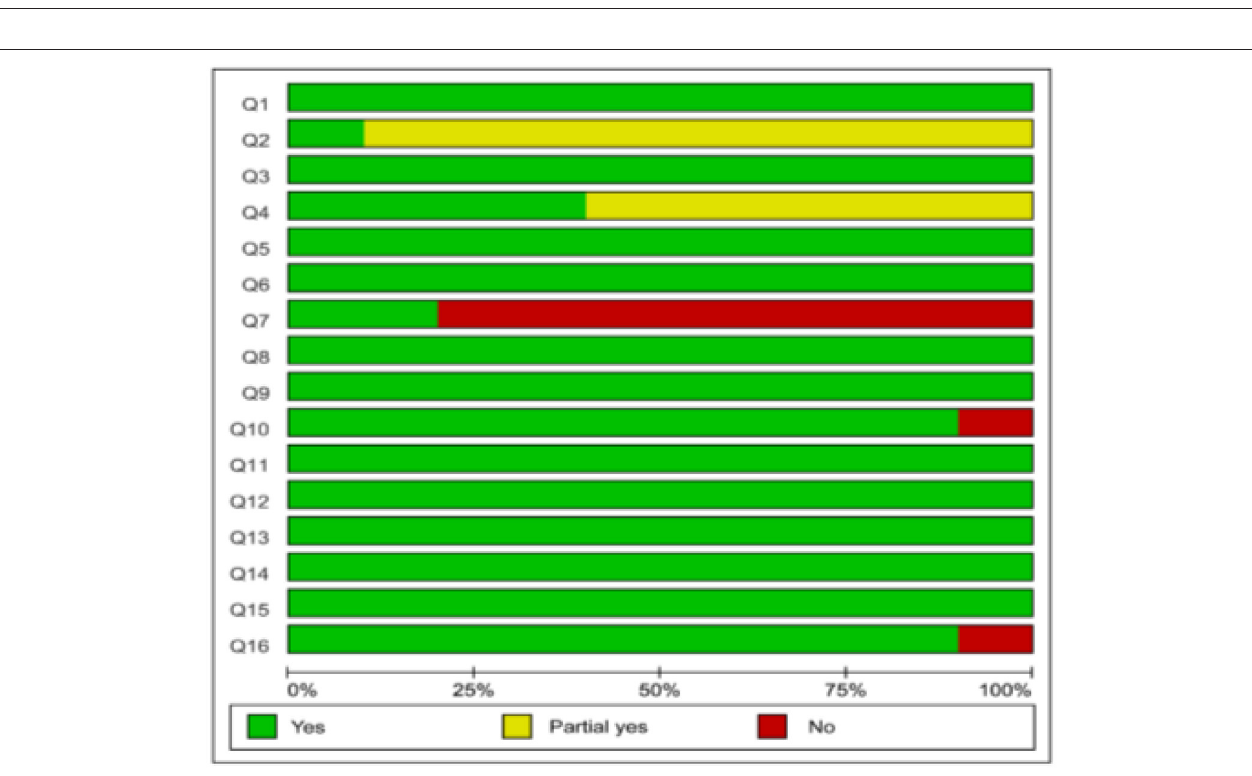
FIGURE 2 | Summary of the Assessment of Multiple Systematic Reviews 2 (AMSTAR-2).